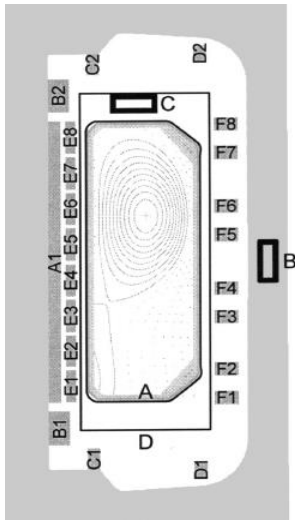
Figure 2. A poloidal cross-section of TCV showing the single ( A and D ) and multi ( B and C ) turn loops used for diamagnetic measurements. The ohmic transformer coils A1, B1, B2, C1, C2, D1 and D2 and the poloidal field shaping coils E1–E8 and F1–F8.